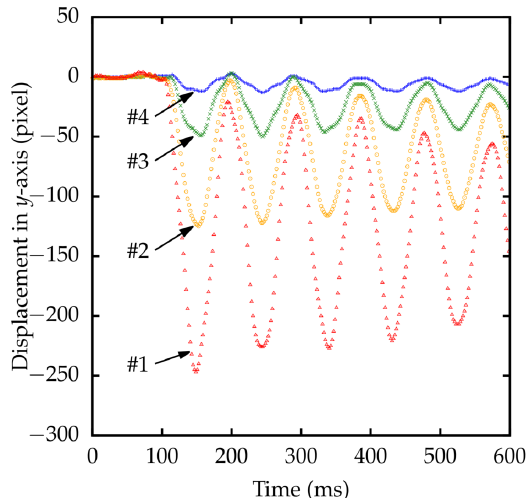
Figure 13. Measured displacement of four markers on a rod. The origin of each marker is its position at time t = 0.